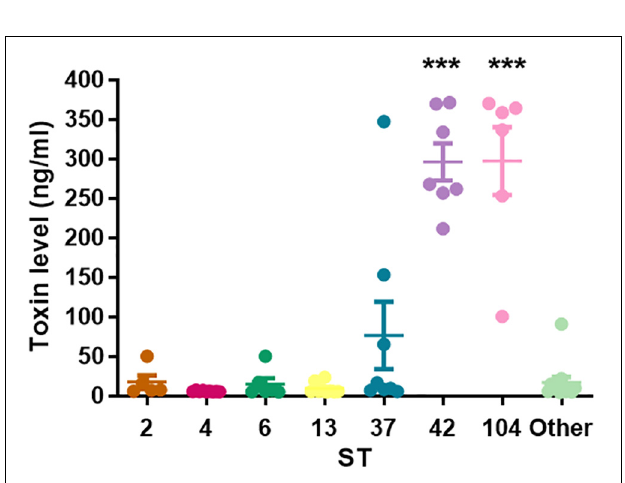
FIGURE 2 | Toxins’ concentrations secreted by different sequence type (ST). The scatter plot showing that ST42 and ST104 were associated with high toxin levels (*** p <